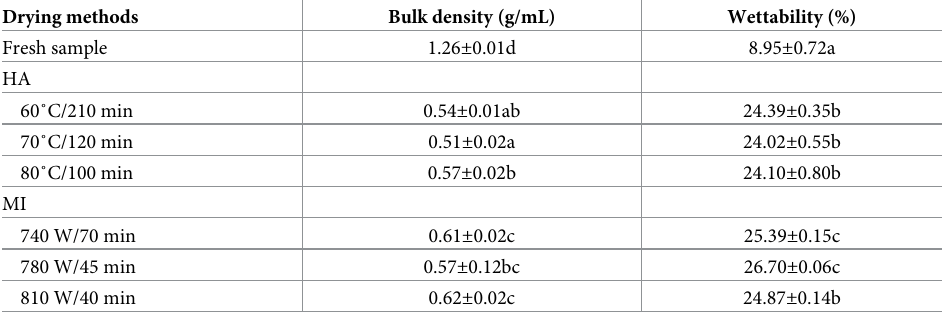
Table 3. Bulk density and wettability of Tai-Pla curry paste (fresh sample) and Tai-Pla curry powder dried using hot air (HA) and hybrid microwave-infrared drying (MI) under different drying conditions. Drying